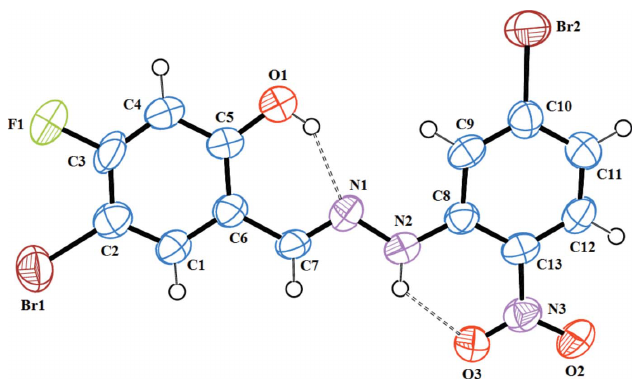
Figure 1 An ORTEP view of 4-bromo-2-{[2-(5-bromo-2-nitrophenyl)hydrazin-1- ylidene]methyl}-5-fluorophenol. Displacement ellipsoids are drawn at the 50% probability level.